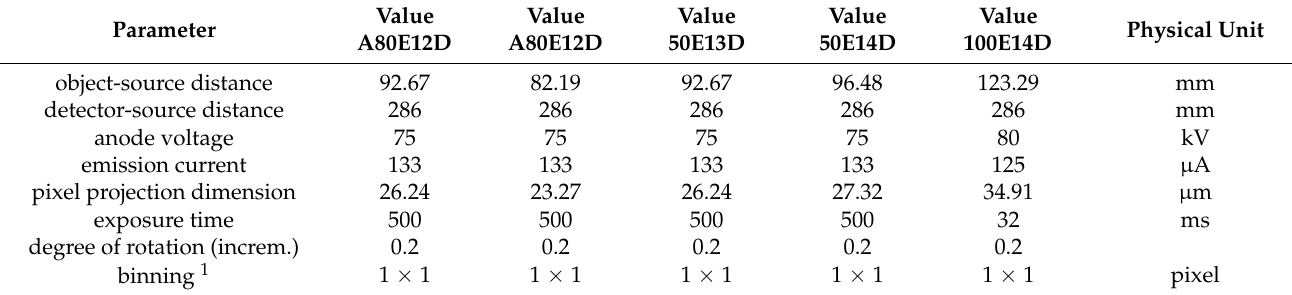
Table A5. Values of set parameters on SkyScan 1275.